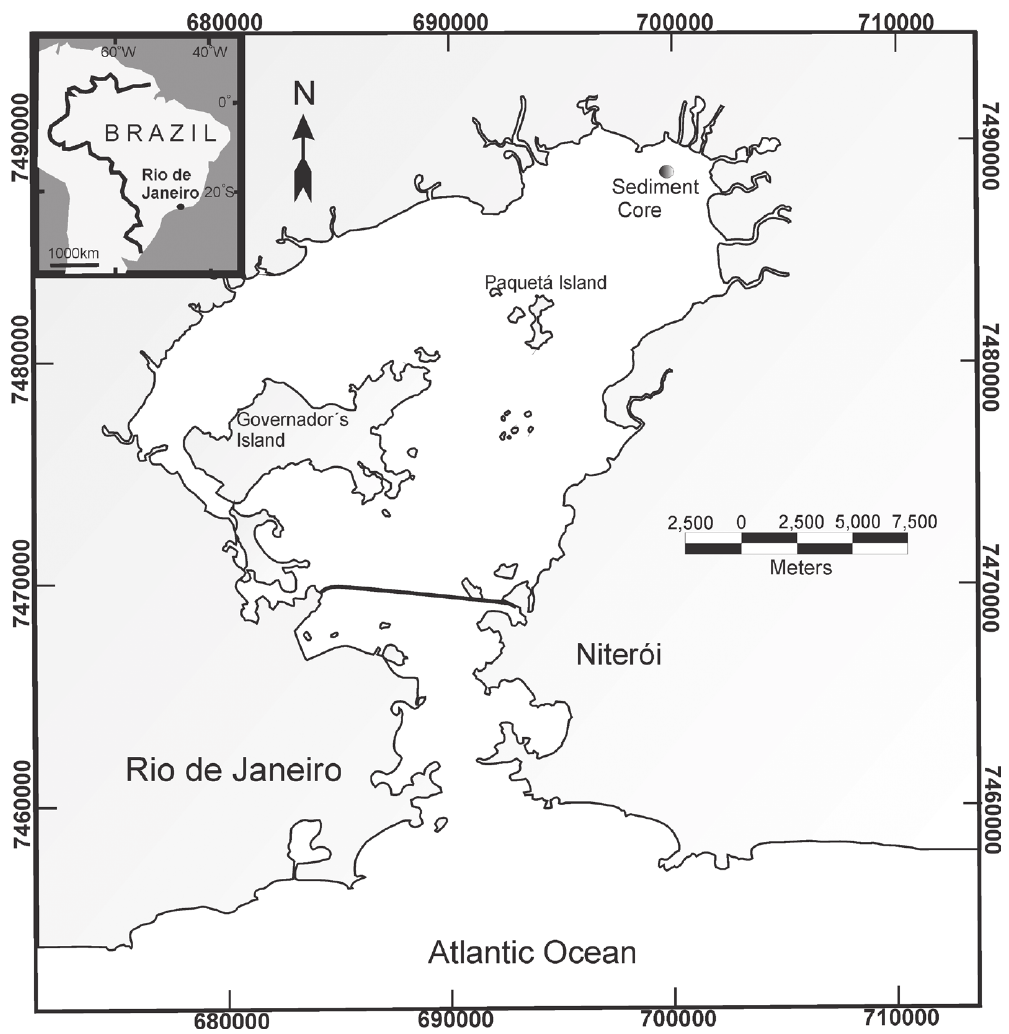
Figure 1 - Map of the location of the studied